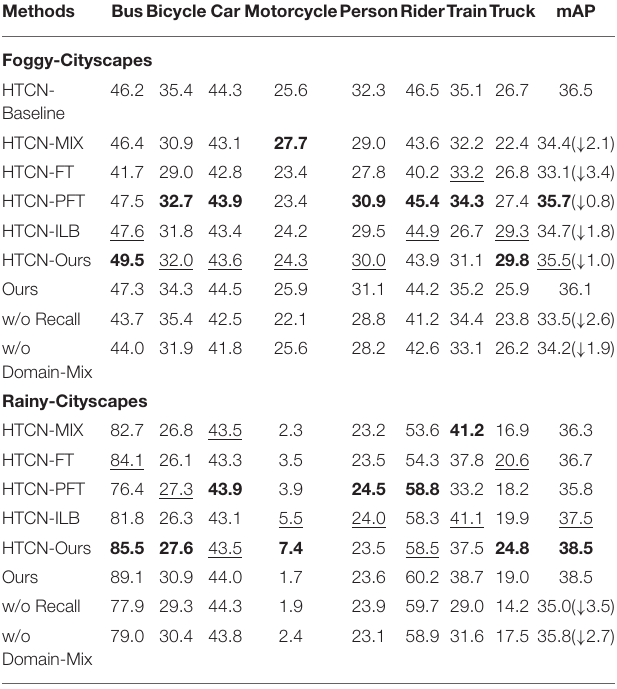
TABLE 2 | Ablation study results on “Diverse Weathers” adaptation.